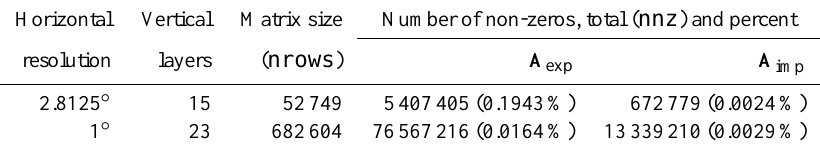
Table 1. Resolution, sizes and sparsity of one block of the explicit and implicit transport matrices for two resolutions computed with the